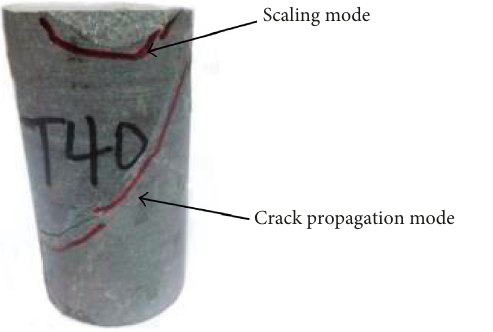
Figure 7: Failure modes of rock samples.